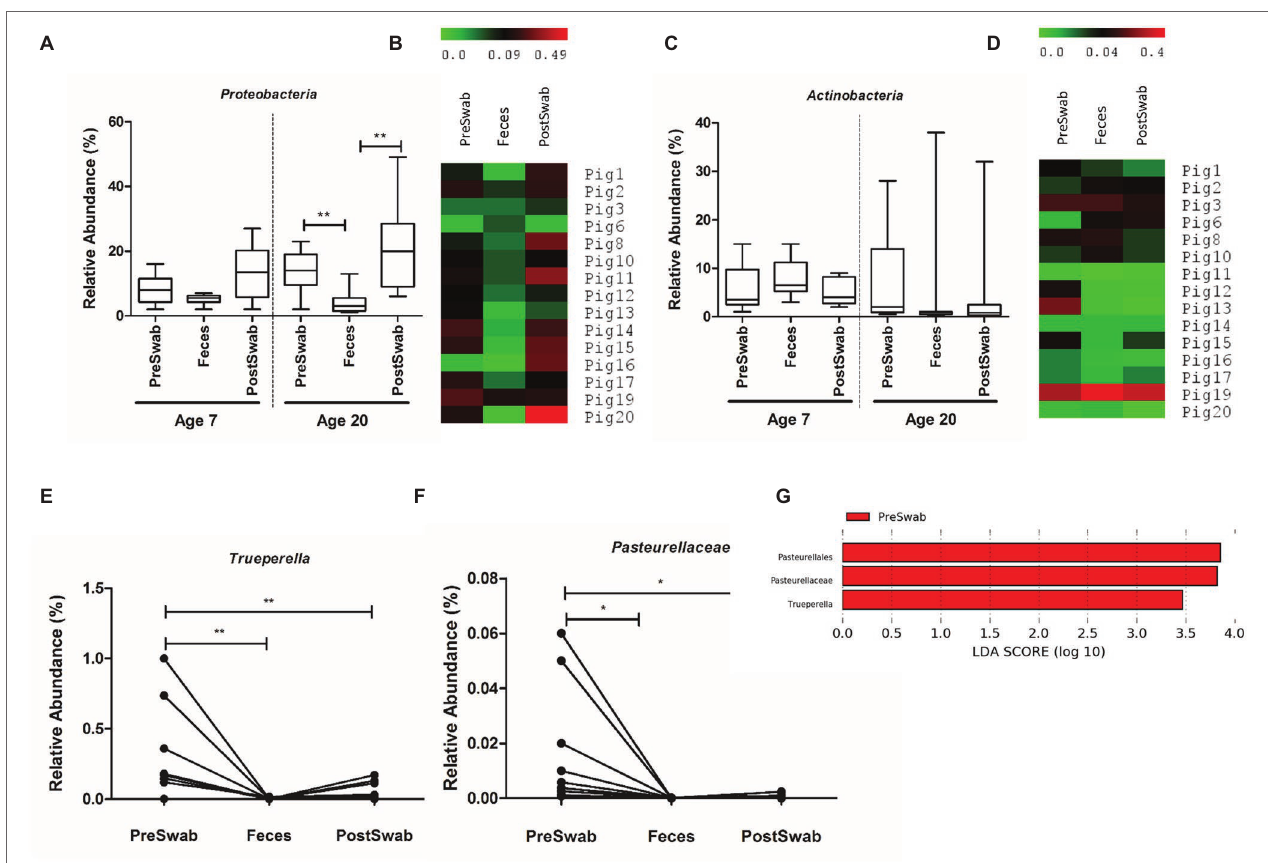
FIGURE 7 | Microbial community composition of sample types. (A,C) Relative abundance of Proteobacteria and Actinobacteria at day 7 and day 20. (B,D) Heat map of relative abundance of Proteobacteria and Actinobacteria at day 20 of all animals. (E,F) Relative abundance of the Trueperella genus and Pasteurellaceae family at day 20 among sample types. (G) LEfSe analysis identified Trueperella genus and Pasteurellaceae family as the only differentially abundant taxa among sample types (* p < 0.05, ** p <